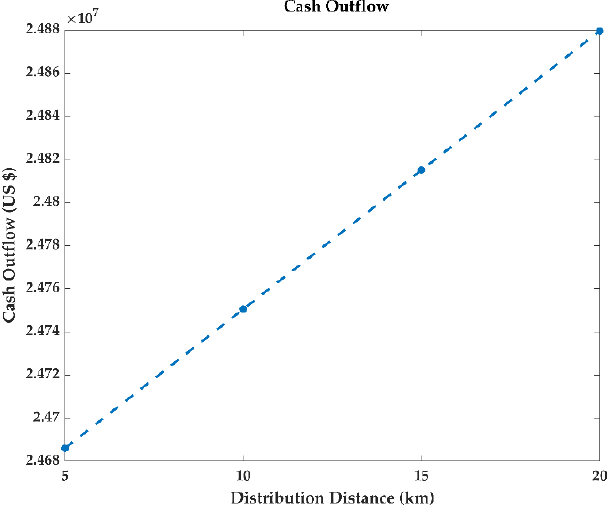
Figure 6. The relation of cash outflow and distribution